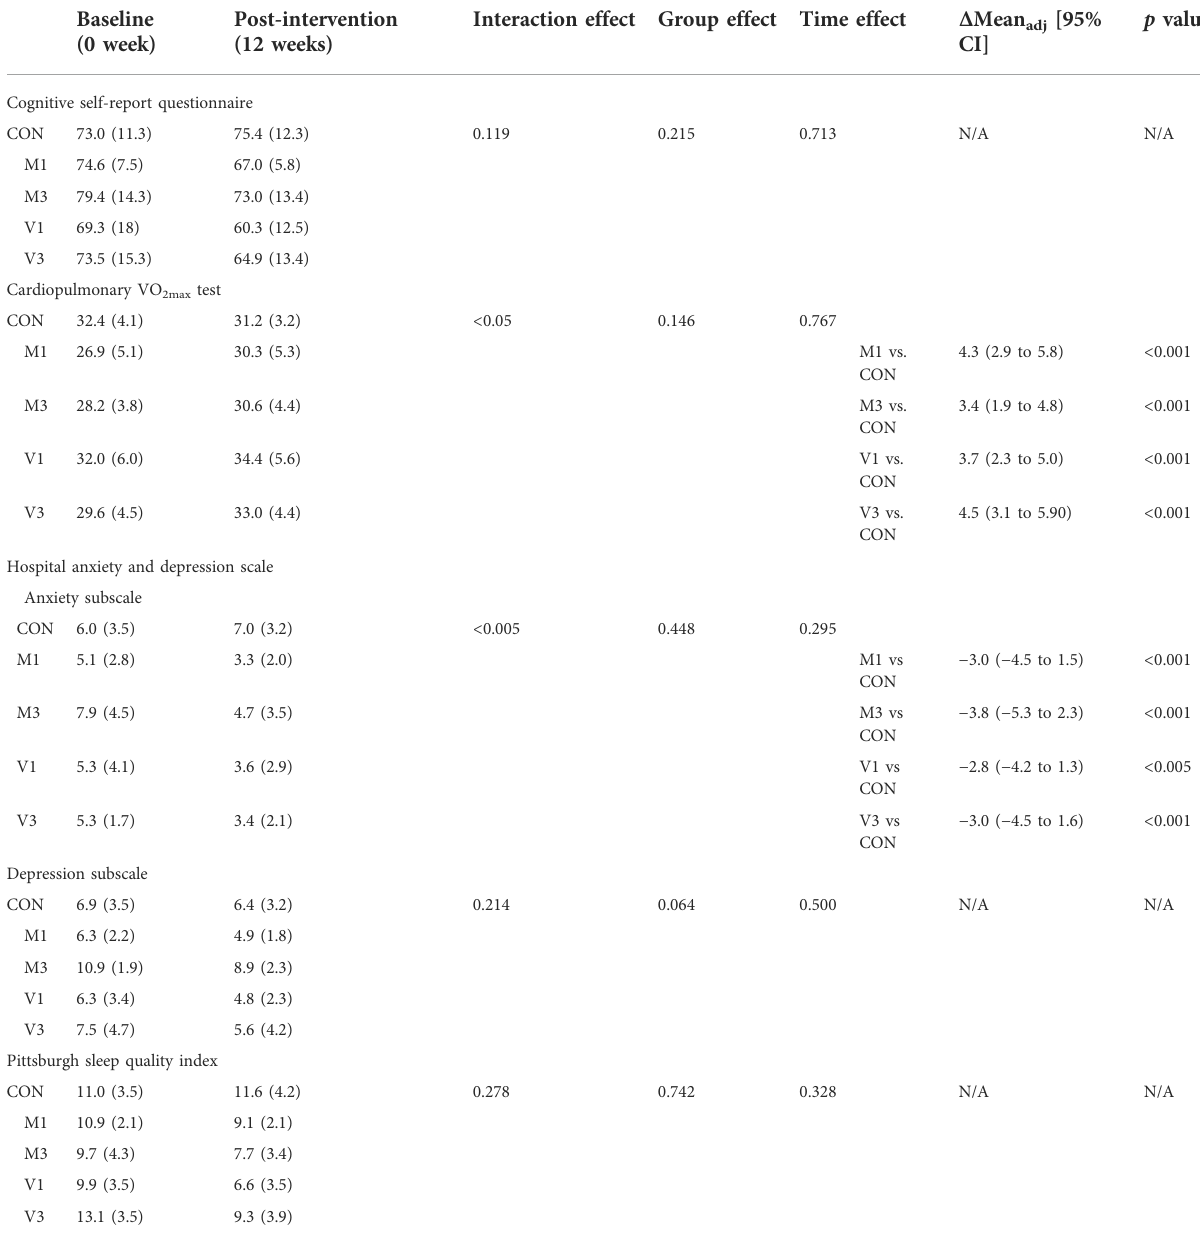
TABLE 2 Summary of secondary